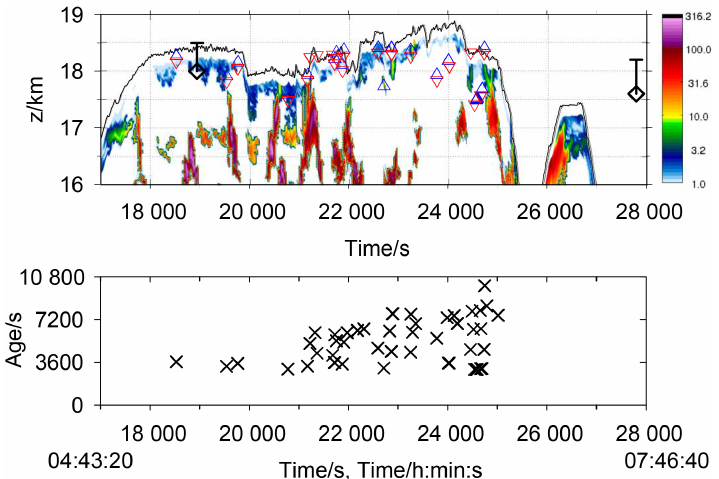
Figure 11. MAL lidar backscatter “curtain” below the Geophysica flight path of 30 November 2005 with computed plume or contrail positions and their ages. Top panel: 532nm backscatter ratio (color scale), averaged over 30s and 42m in time and vertical directions, versus time. Triangles identify altitudes/times of plumes in the curtain, with red or blue symbols for primary or secondary wakes. The diamonds with one-sided error bars represent the cloud-top altitude derived from NOAA-AVHRR data for optically thick cloud tops, with an estimated altitude range of optically thinner clouds above. Bottom: ages of penetrated plumes versus